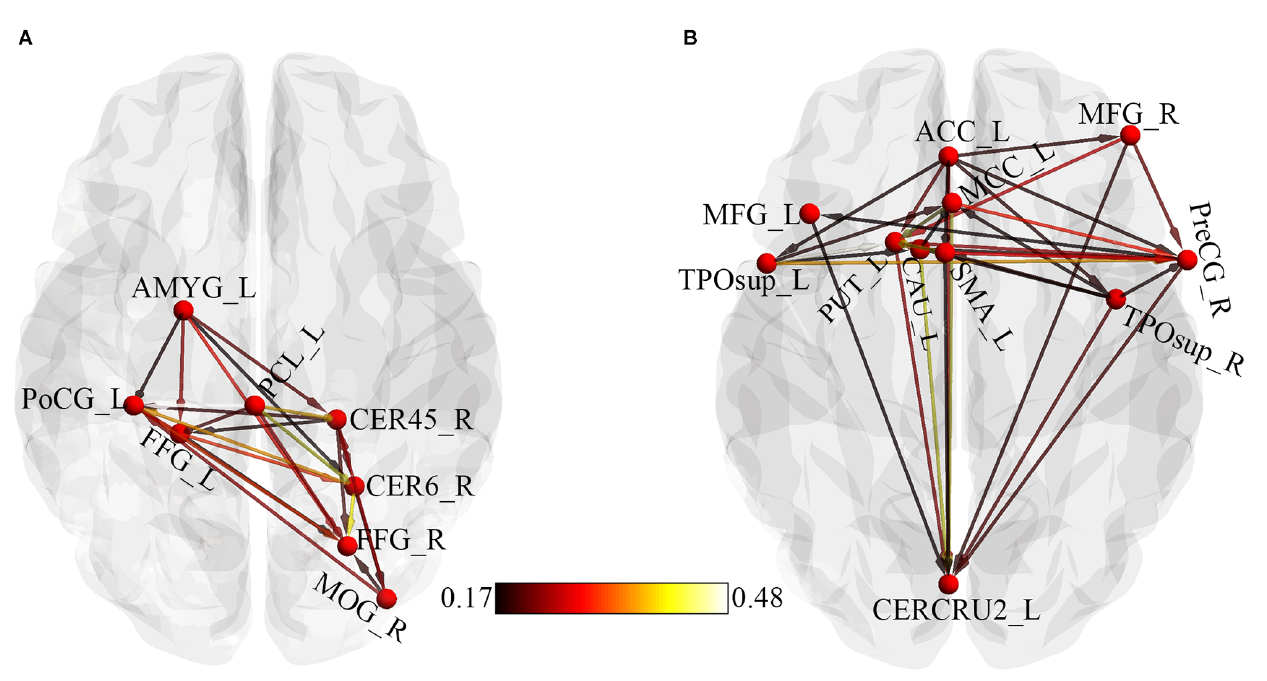
FIGURE4 ROI-Wise GCA showing causal relationships among ROIs. (A) Causal relationships among outflow ROIs. (B) Causal relationships among inflow ROIs. The color bar indicates the connectivity strength. AMYG, Amygdala; PoCG, Postcentral gyrus; PCL, Paracentral lobule; CER45, Cerebellum_4_5; CER6, Cerebellum_6; FFG, Fusiform gyrus; MOG, Middle occipital gyrus; L, Left; ACC, Anterior cingulate cortex; MCC, Middle cingulate cortex; MFG, Middle frontal gyrus; TPOsup, Temporal pole: superior temporal gyrus; R, Right; PreCG, Precentral gyrus; SMA, Supplementary motor area; CAU, Caudate; PUT, Putamen; CERCRU2,